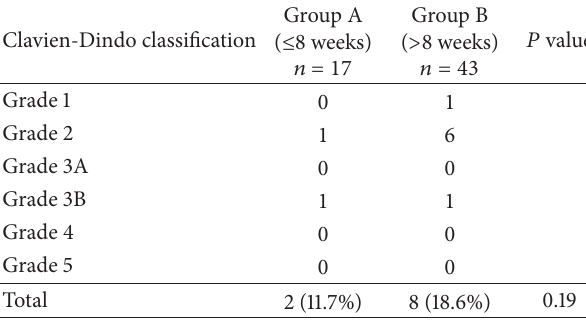
Table 4: Postoperative complications.